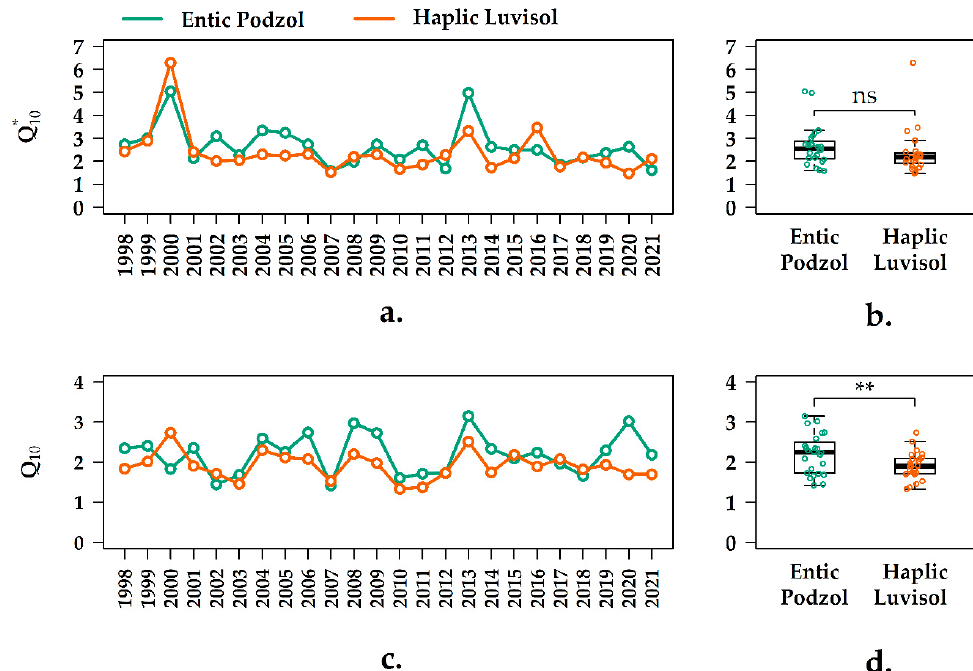
Figure 4. Dynamics of Q* 10 and Q 10 values in the two forests during the observation period ( a , c ) and their statistical characteristics ( b , d ): the median (bar), lower (Q1) and upper (Q3) quartiles (“boxes”); X1 = Q1–1.5 IQR (interquartile range IQR = Q3–Q1) and X2 = Q3–1.5 IQR (“moustaches”). All data are shown as dots. ns—the difference between mean values is not significant. **—the difference is significant at p <